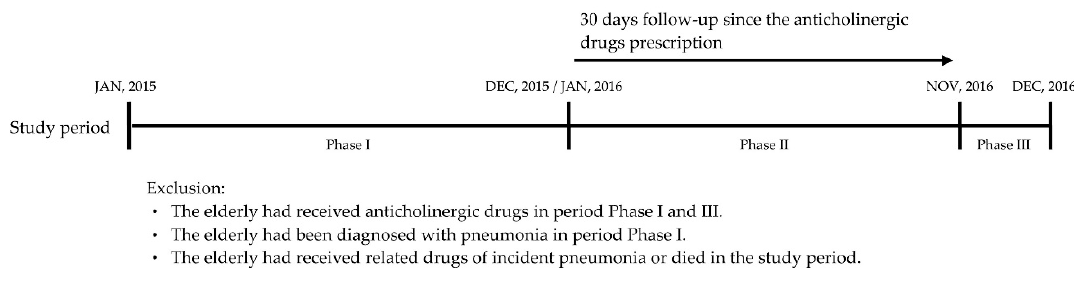
Table 1. The distribution of prescriptions in elderly patients.